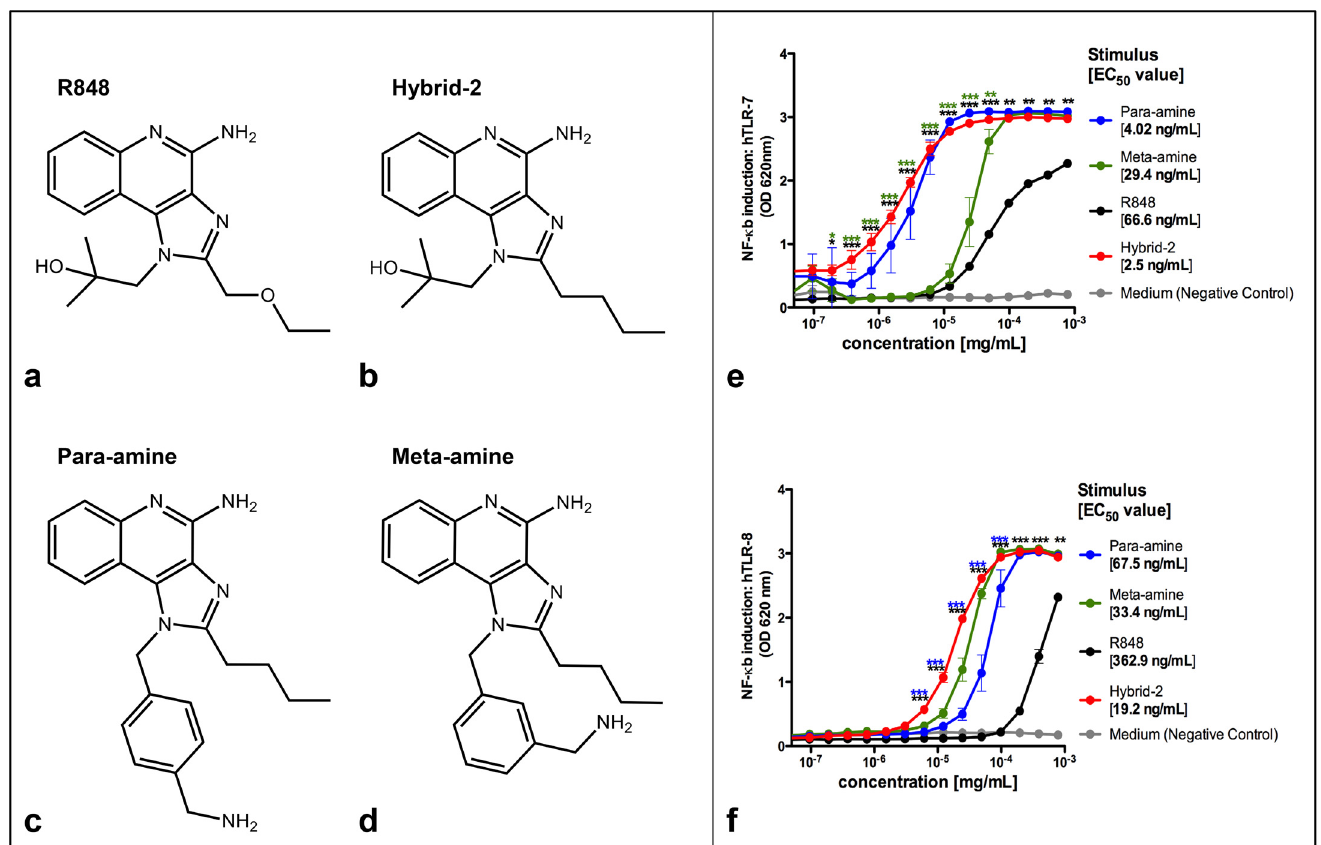
Fig 1. NF- κ B induction by TLR7/8 agonists in HEK-TLR cells. Four TLR7/8 agonists were compared. (A) Structure of R848, (B) Structure of Hybrid-2, (C) Structure of para-amine and (D) Structure of meta-amine. HEK-293 cells transfected with (E) human TLR7 and (F) TLR8 and an NF- κ B-driven reporter SEAP gene were stimulated for 18 – 24 h with TLR agonists. The y-axis shows the level of SEAP activity in the Quanti-blue assay optical density (OD). The x-axis shows the concentration of each compound in mg/ml. Each data point represents the mean ± SD of OD at 650 nm of triplicate culture wells. HEK detection medium alone (negative control) is represented in gray. The TLR7/8 benchmark agonist R848 is represented in black; The TLR 7/8 agonists Para-amine, Meta-amine and Hybrid-2 are represented in blue, green and red respectively. Three stars indicate significance of p < 0.001 (t test) and two green indicate significance of p < 0.01 (t